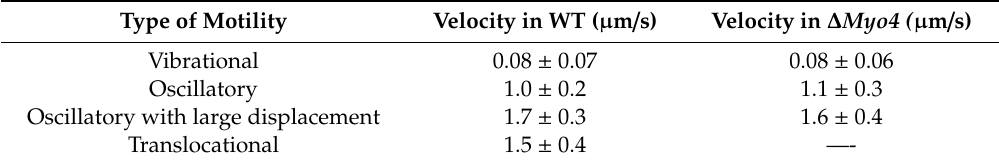
Table 4. Motility types of MFA2 granules in ∆ myo4 vs. WT